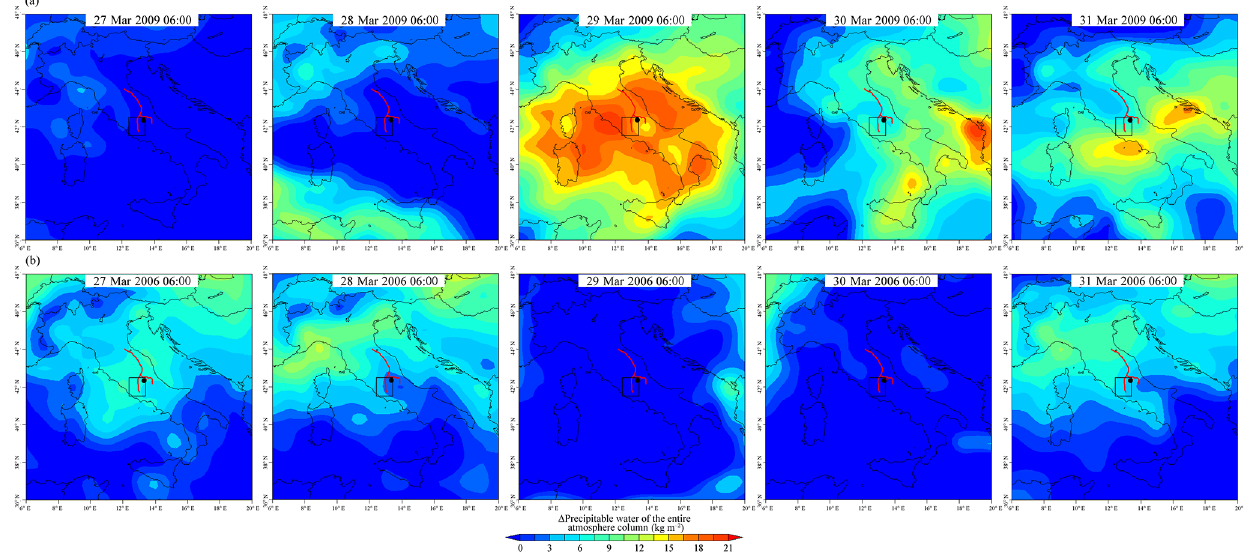
Figure 6. Spatial distributions of deviated precipitable water of the entire atmosphere column ( (cid:49) PWATclm) at 06:00UTC from 28 March to 1 April 2009 (a) and 2006 (b) , respectively. The black spot indicates the epicenter of the mainshock, the black rectangular box indicates the epicenter pixel, and the red line indicates the related main fault system.